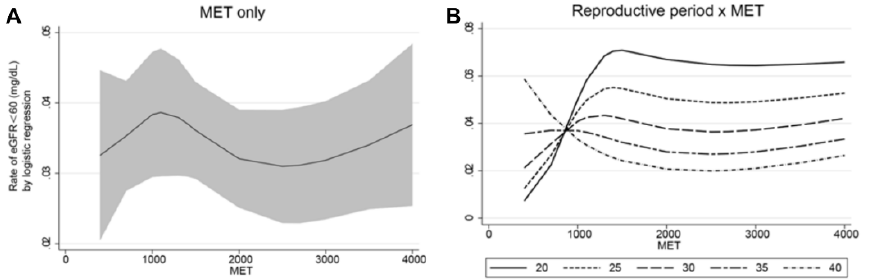
Figure 2. The marginal effect of metabolic equivalents in women with different fixed reproductive periods on decreased estimated glomerular filtration rate (eGFR). ( A ) MET on developing eGFR < 60 mL/min/1.73 m 2 . ( B ) The interaction effect of the length of the reproductive period and amount of physical activity on developing eGFR < 60 mL/min/1.73 m 2 . Adjusted variables: age, body mass index, parental history of chronic kidney disease, age at menarche, pregnancies, hormone replacement therapy, education, smoking, alcohol intake, hypertension, hyperlipidemia, blood urea nitrogen, hemoglobin, albumin, and uric acid.